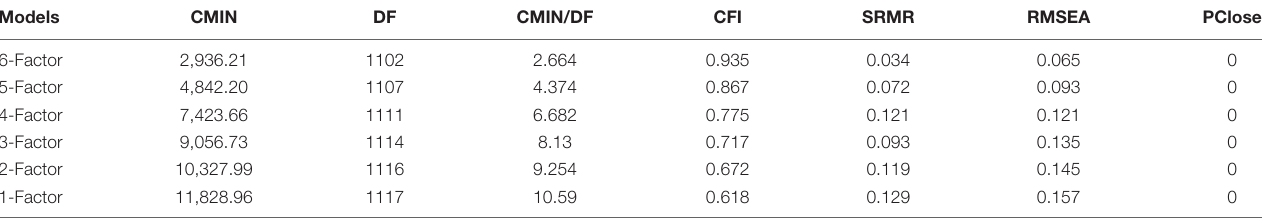
TABLE 1 | Confirmatory factor analysis (CFA).